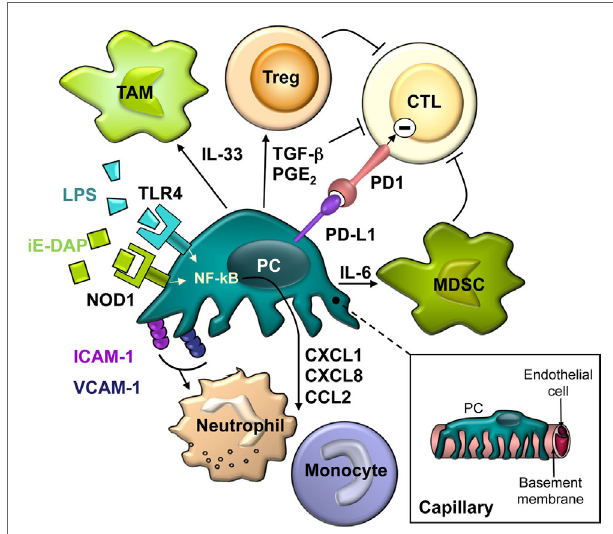
FiGURe 1 | The schematic drawing describes the close spatial relationship and the complex interactions between pericytes and different cells of the innate and adaptive immune system